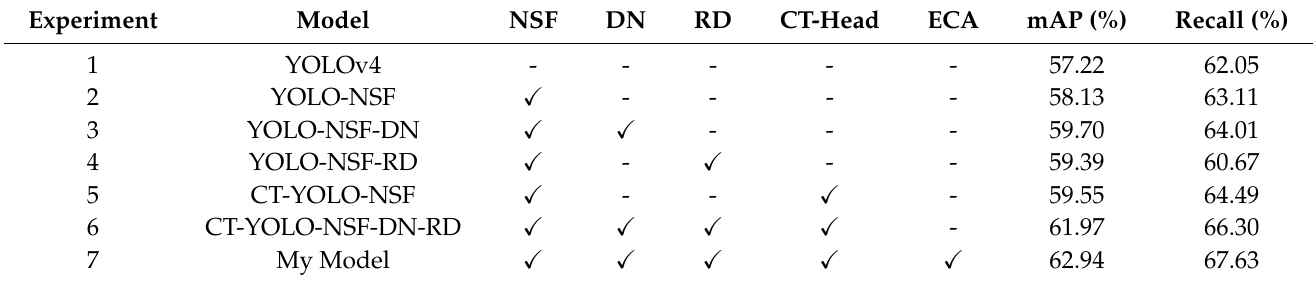
Table 1. Structure and results of ablation experimental